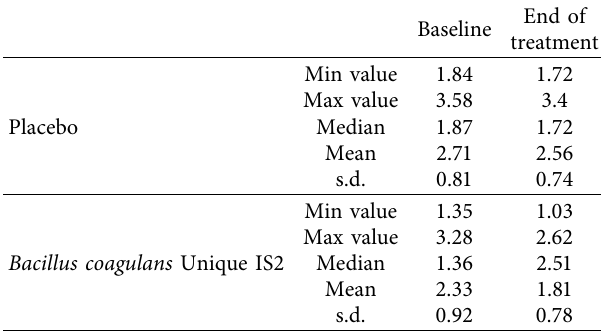
Table 3: Plaque mutans streptococci scores at baseline and EOT.